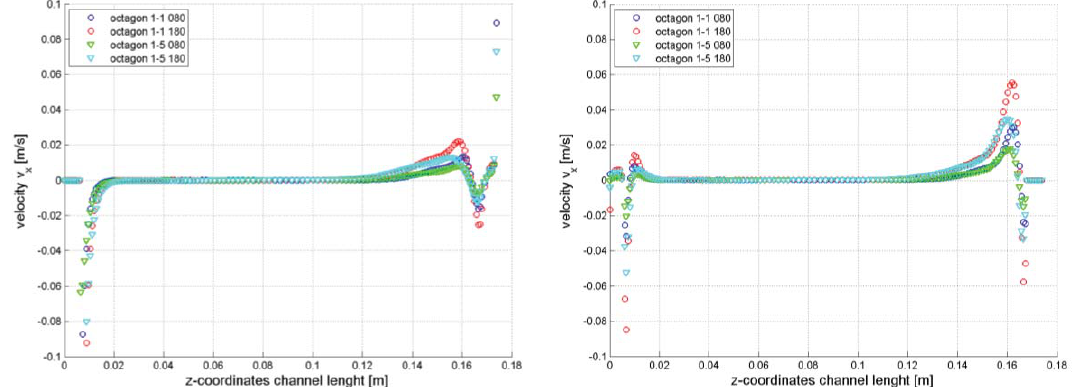
Figure 13: Development of velocity v X in an open and closed